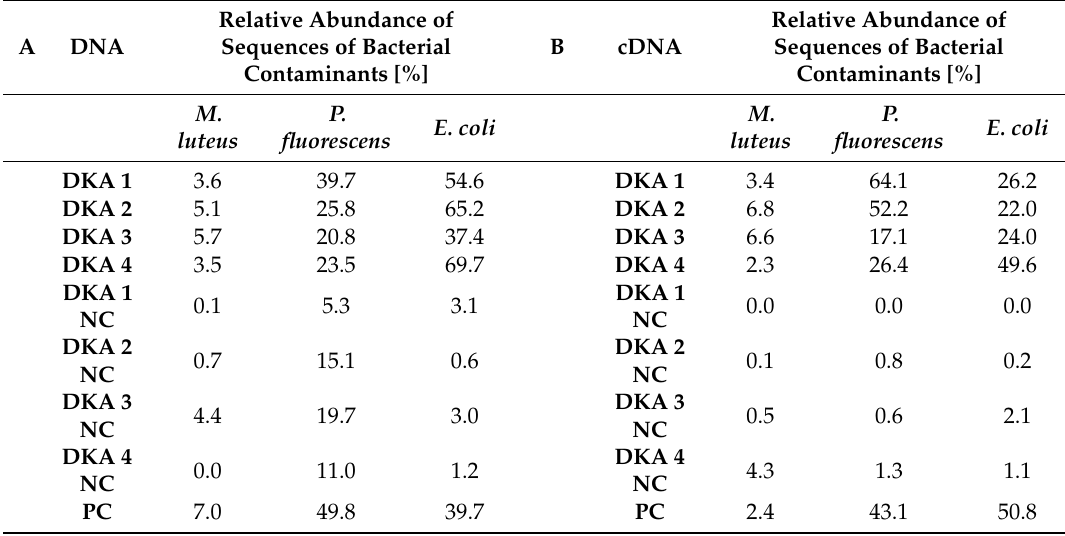
Table 1. Relative OTU abundances were calculated for each tick and summarized decontamination strategies by the OTU count table for DNA or cDNA samples (Supplementary Tables S2 and